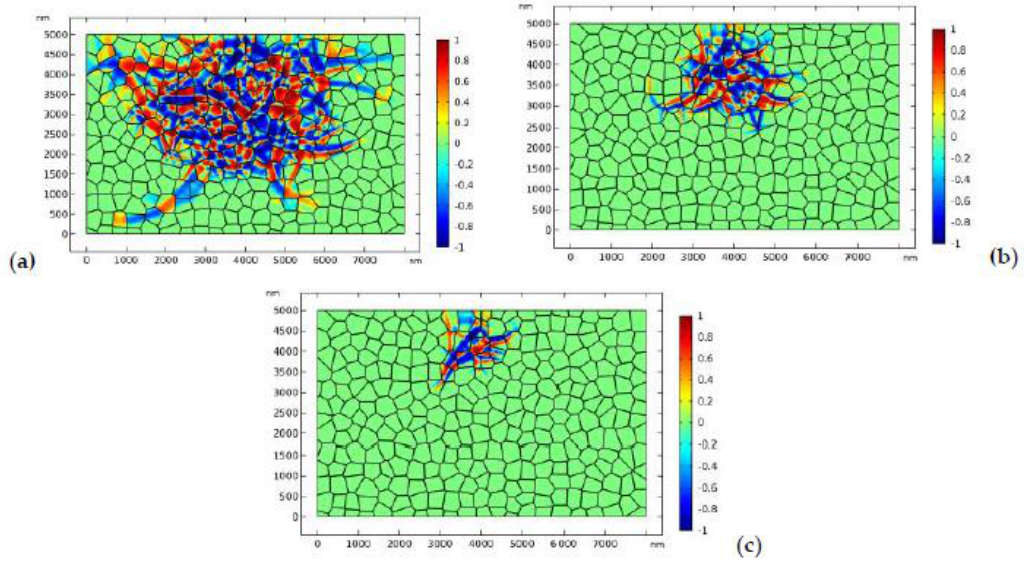
Figure 4. The equilibrium phase patterns around the crack tip at different ambient temperatures: ( a ) T = 1340 K; ( b ) T = 1360 K; and ( c ) T = 1380 K. The applied load is σ a = 90